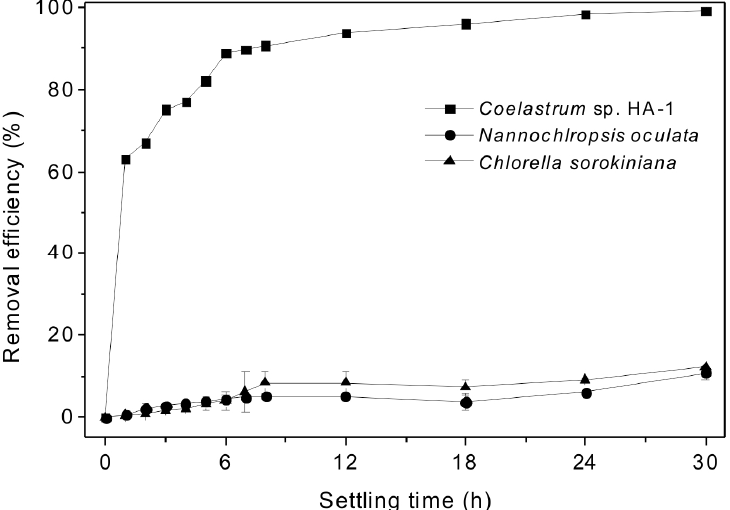
Figure 4. Microalgae removal efficiency of Coelastrum sp. HA-1, Nannochloropsis oculata and Chlorella sorokiniana